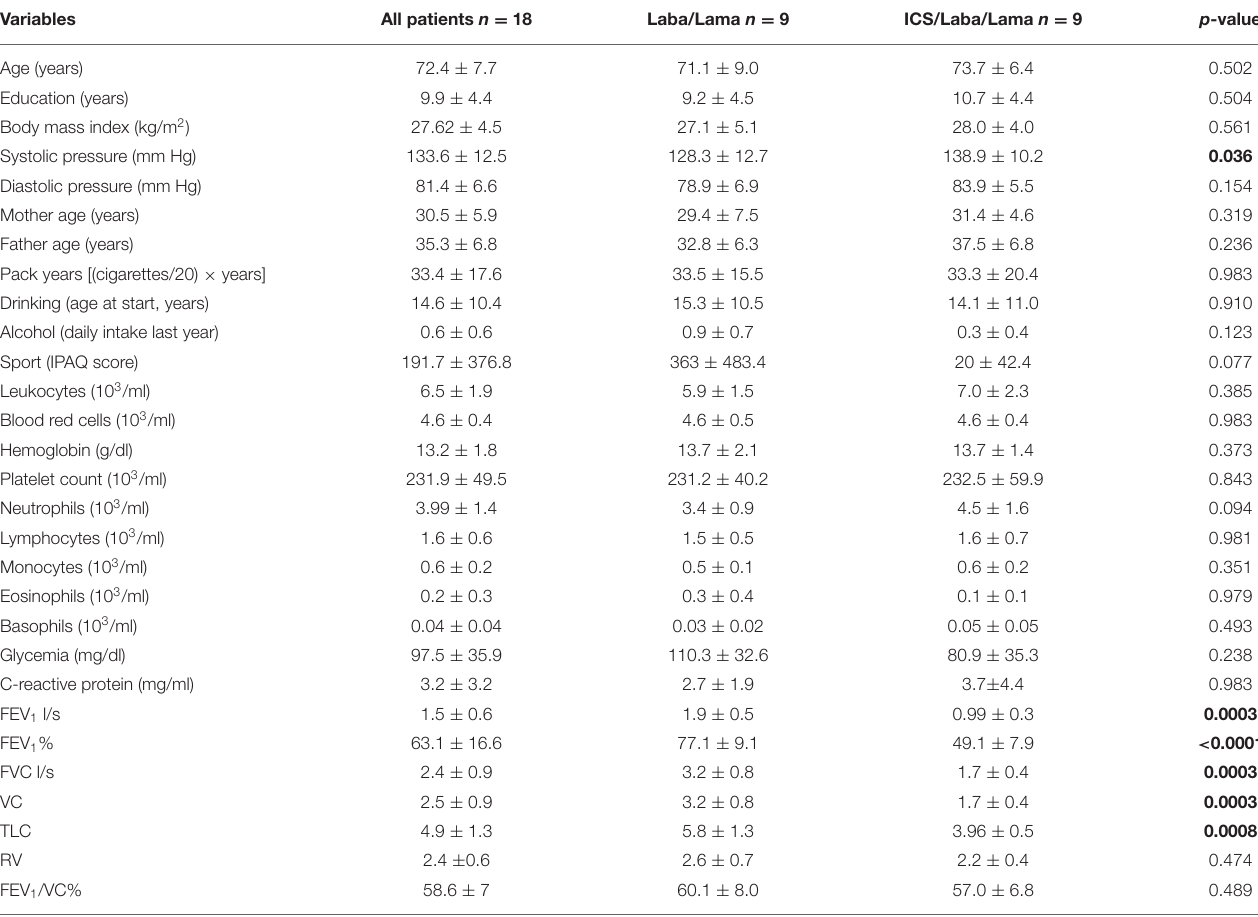
TABLE 1 | Interval variables in COPD patients with long-acting β 2 agonist (LABA)/long-acting muscarinic antagonist (LAMA) and inhaled corticosteroid (ICS)/LABA/LAMA treatments (mean ± SD) and p -values of the Mann–Whitney test comparing the two groups.